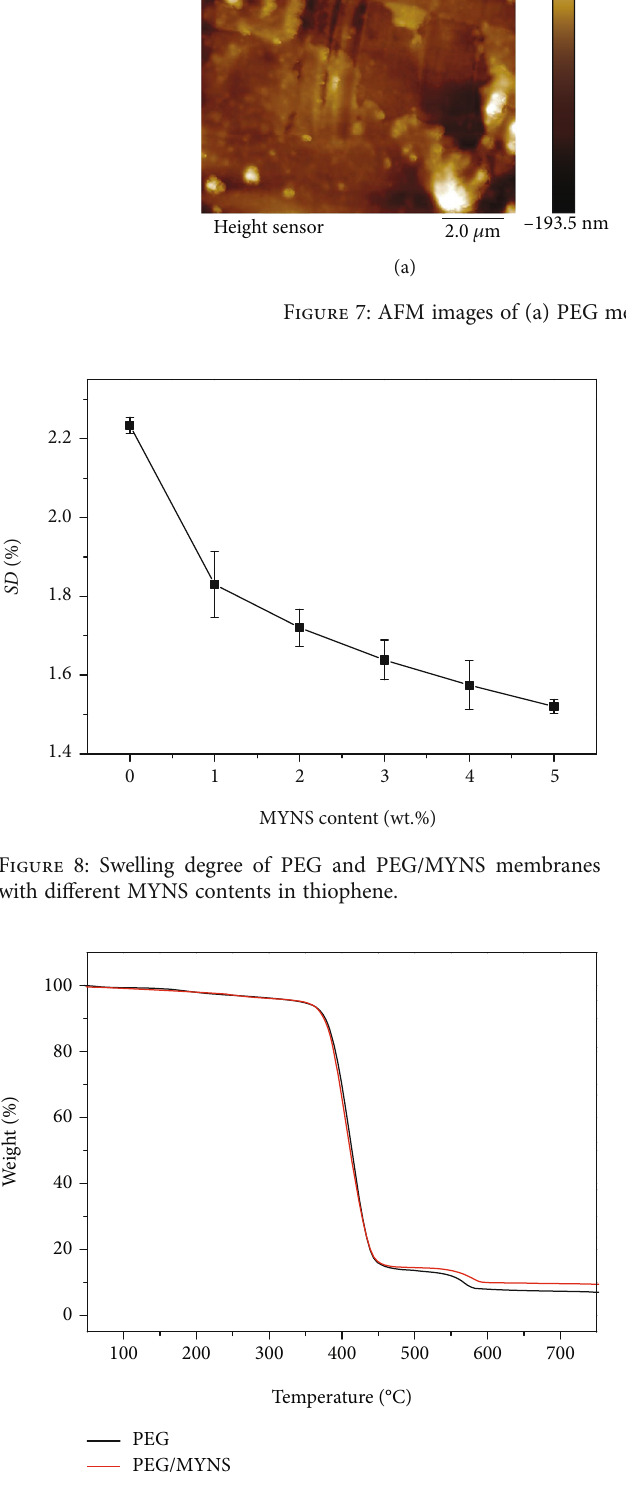
Figure 9: TGA curves of PEG and PEG/MYNS membranes.